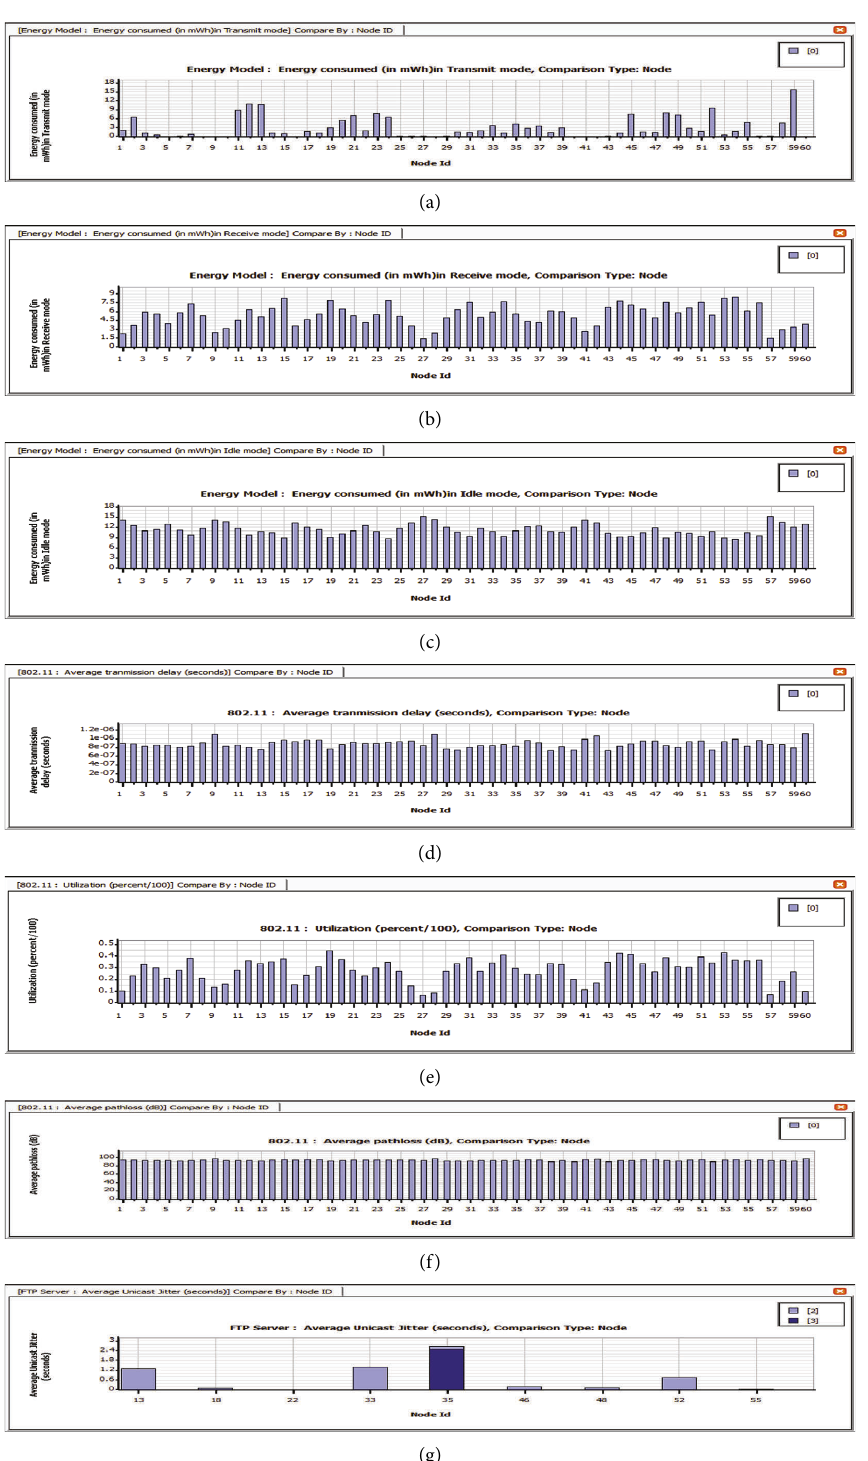
Figure 11: (a) Transmit mode energy consumption of LAR1 for FTP deployment. (b) Receive mode energy consumption of LAR1 for FTP deployment. (c) Idle mode energy consumption of LAR1 for FTP deployment. (d) Average transmission delay of LAR1 for FTP deployment. (e) Percentage of utilization of LAR1 for FTP deployment. (f) Average pathloss of LAR1 for FTP deployment. (g) Average iitter of LAR1 for FTP